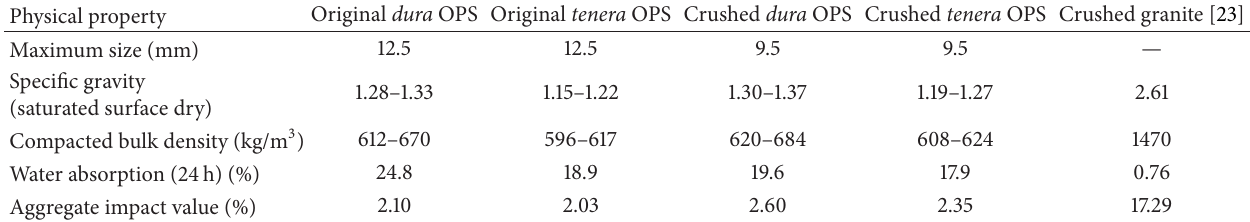
Table 2: Comparison between the physical properties of OPS aggregates and crushed granite [22].